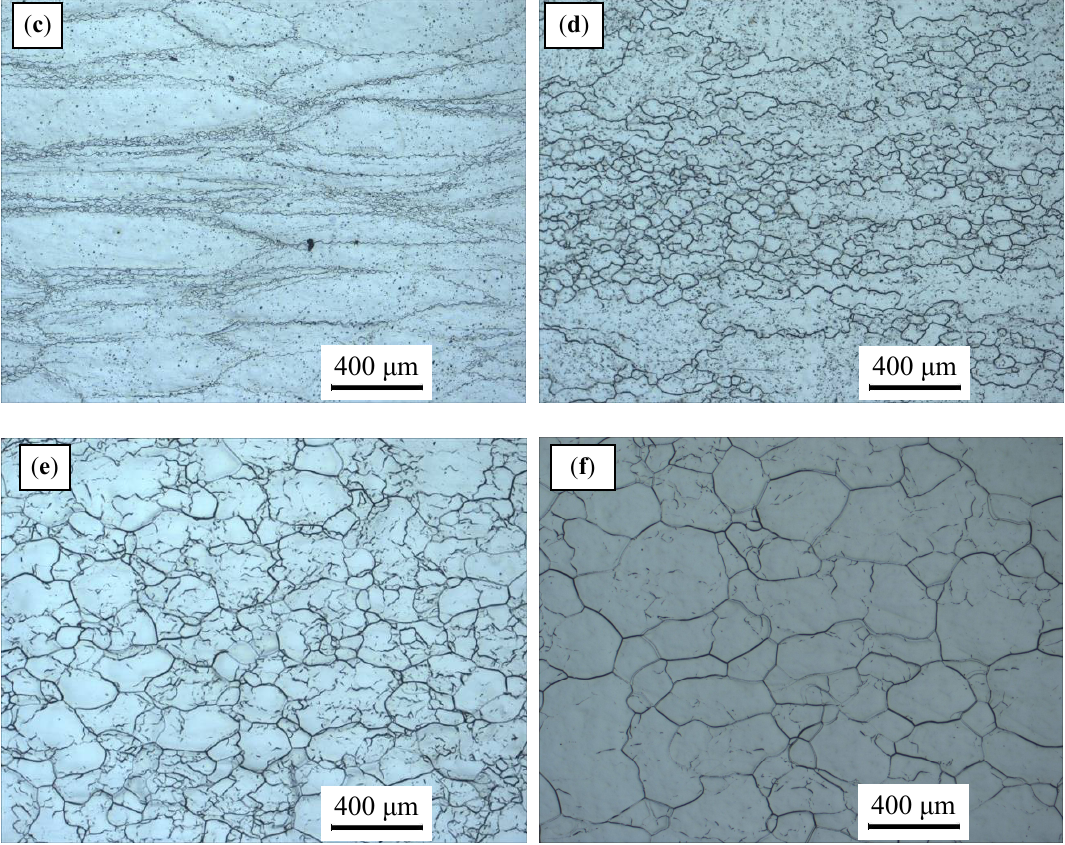
Figure 4. Optical microstructures of ZrTiAlV alloy under different hot-working conditions at the true strain of 0.7: ( a ) 850 °C, 1 s −1 ; ( b ) 900 °C, 1 s −1 ; ( c ) 950 °C, 0.1 s −1 ; ( d ) 1000 °C, 0.01 s −1 ; ( e ) 1000 °C, 0.001 s −1 ; and ( f ) 1050 °C, 0.001 s −1 .